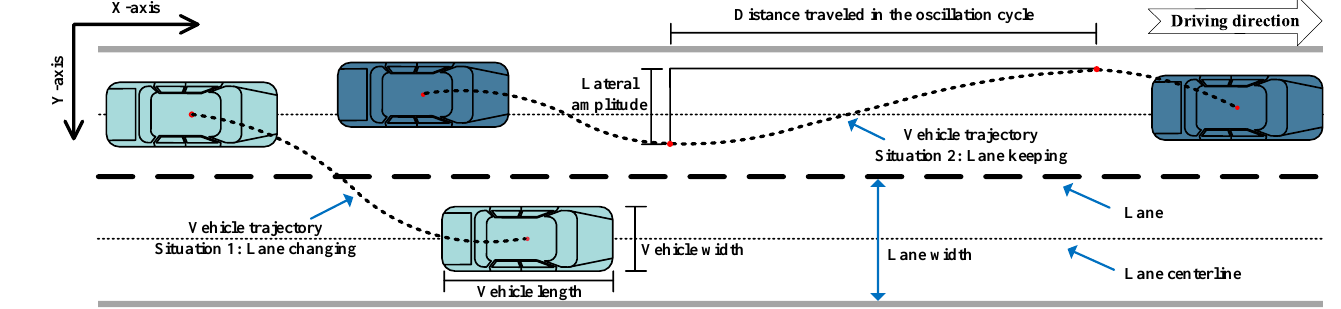
Figure 3. Schematic of lateral oscillation of vehicle